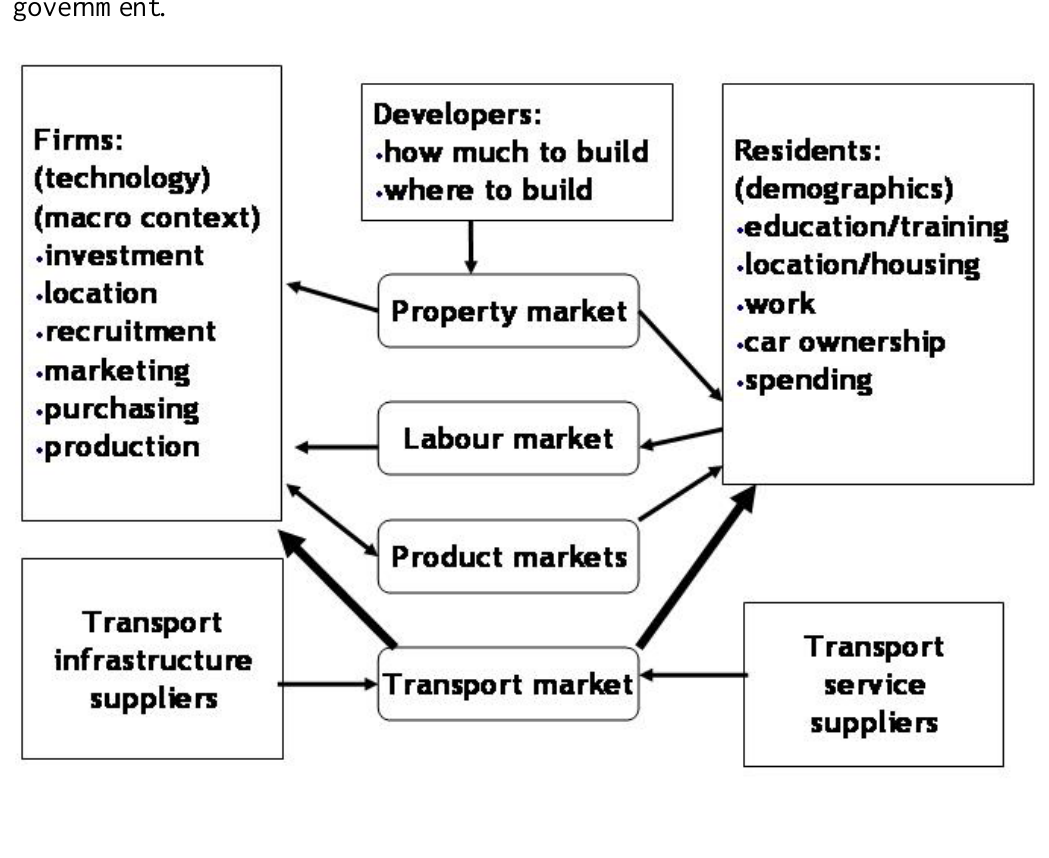
Figure 1. Key decisions by land-use